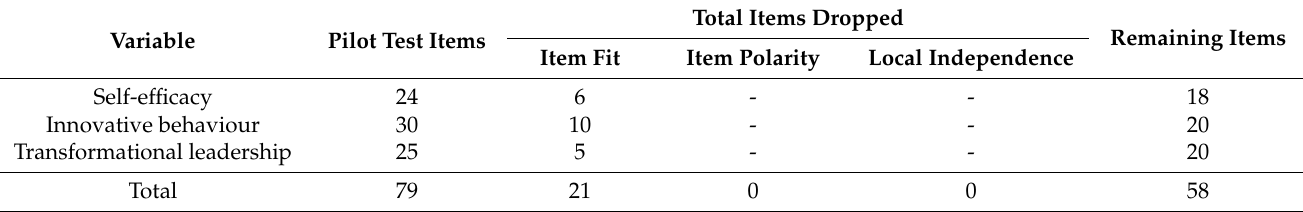
Table 14. Total items dropped in pilot